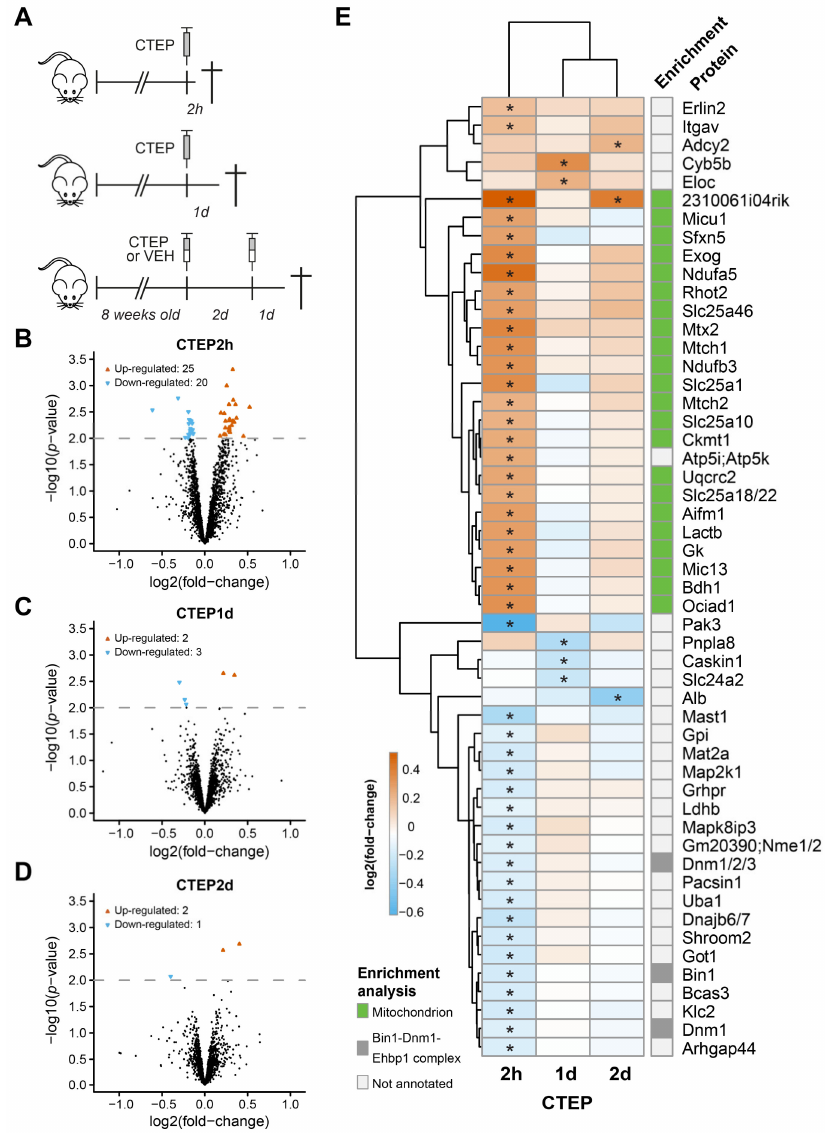
Figure 3. Quantitative proteomics analysis of synaptosomes of CTEP-treated mice. ( A ) Experimental design. Adult WT mice were treated with CTEP or vehicle and sacrificed 2 (CTEP2h), 24 (CTEP1d) and 48 h (CTEP2d) after the first administration as indicated (N = 6). ( B – D ) Volcano plots showing the distribution of fold-change protein expression in CTEP-treated mice synaptosomes from the CTEP2h ( B ), CTEP1d ( C ) and CTEP2d ( D ) groups compared to vehicle control. Proteins above the dotted line were considered significantly regulated (eBayes p < 0.01). ( E ) Heatmap showing the differentially abundant synaptosome proteins between CTEP-treated and control mice. Color gradient (blue-red) indicates the fold changes compared to vehicle control. Asterisks indicate the experimental group in which the protein was found significantly regulated. Proteins were annotated according to gene ontology enrichment